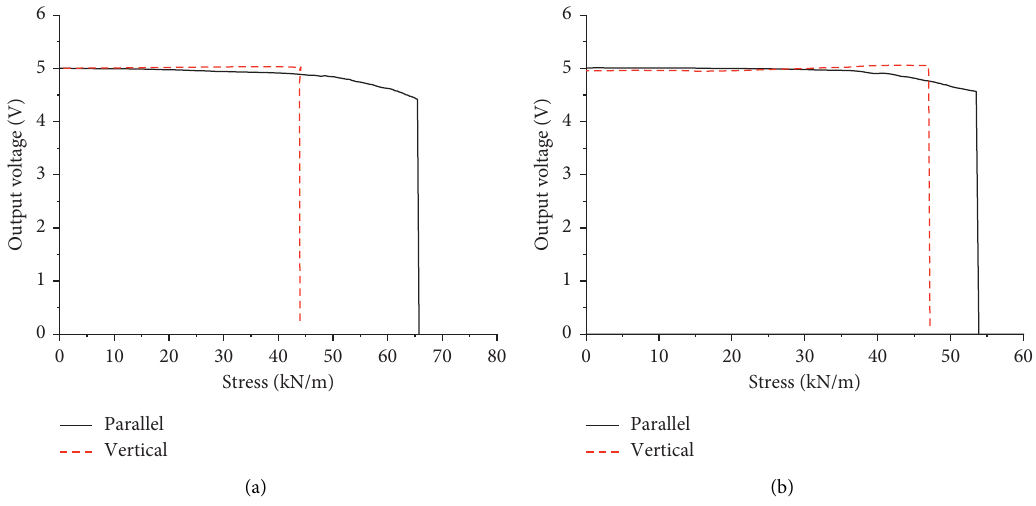
Figure 14: Output voltage-stress curve of the square specimen. (a) Warp. (b) Weft.